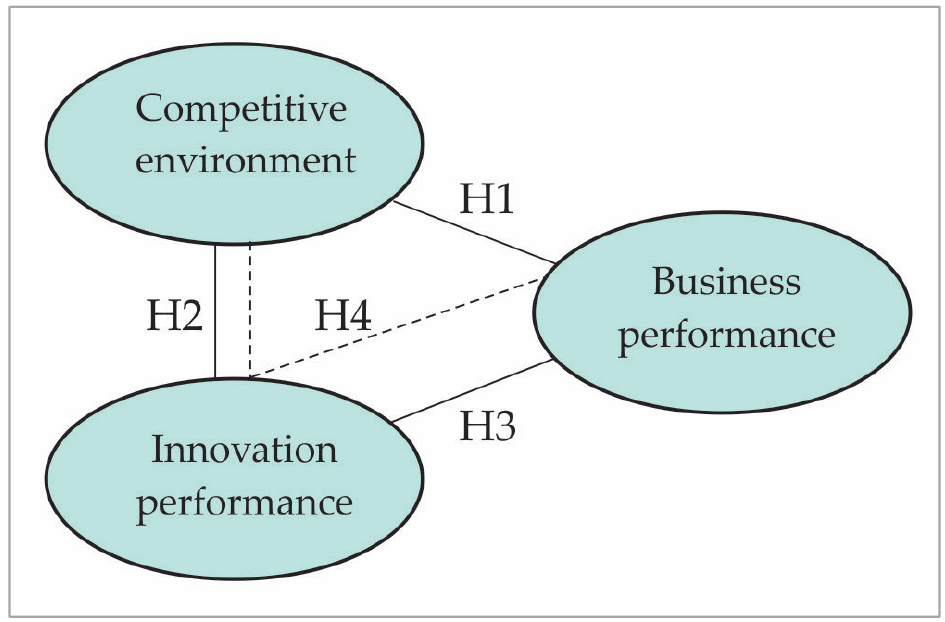
Figure 1. A hypothetical model relating competitive environment, innovation performance and business performance.